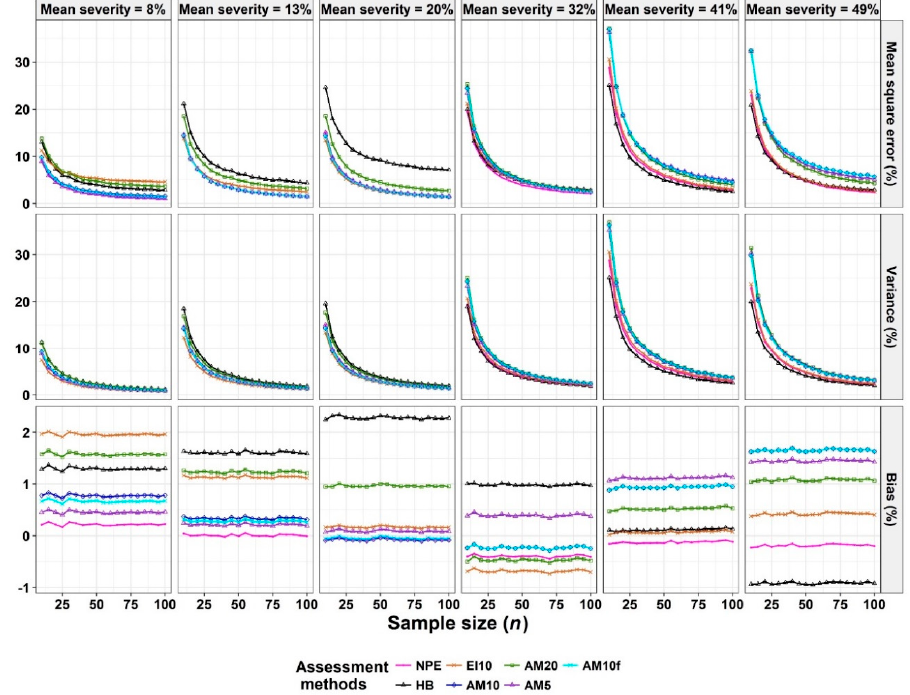
Figure 8. Results in relation to the actual mean severity of peach scab (caused by Venturia nashicola ) as measured using image analysis on leaves from six plots in Dongshi District, Taichung County, Taiwan. Plots were sampled from September to November 2018. The results show the relationships between the mean squared error (MSE), or variance, or bias of the mean disease severity estimates and sample size ( n ) (from 10 to 100 in 5 increments) for each of the different scales used, at the six mean disease severities of 8, 13, 20, 32, 41, and 49% with corresponding variances of 0.0091, 0.0146, 0.0146, 0.0192, 0.0287, and 0.0231%, respectively. Assessment methods: (i) NPE (nearest percentage